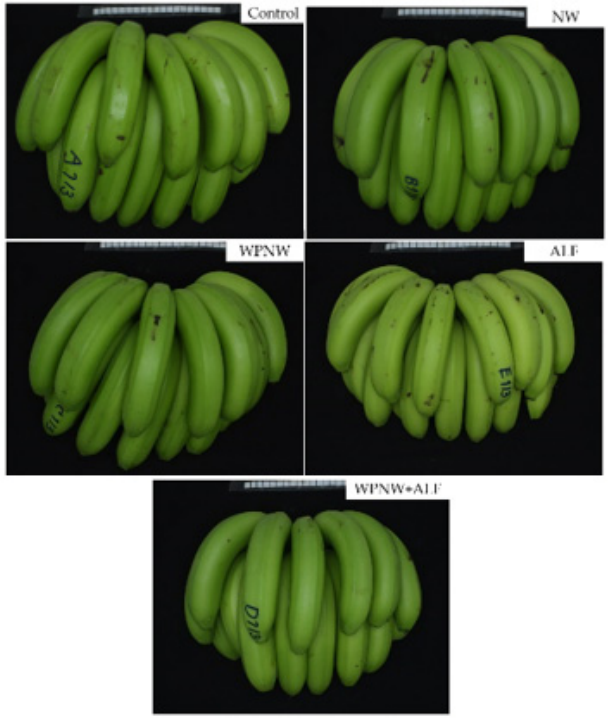
Figure 8. No sunburn (SB) incidence at mature green stage from the summer trial.